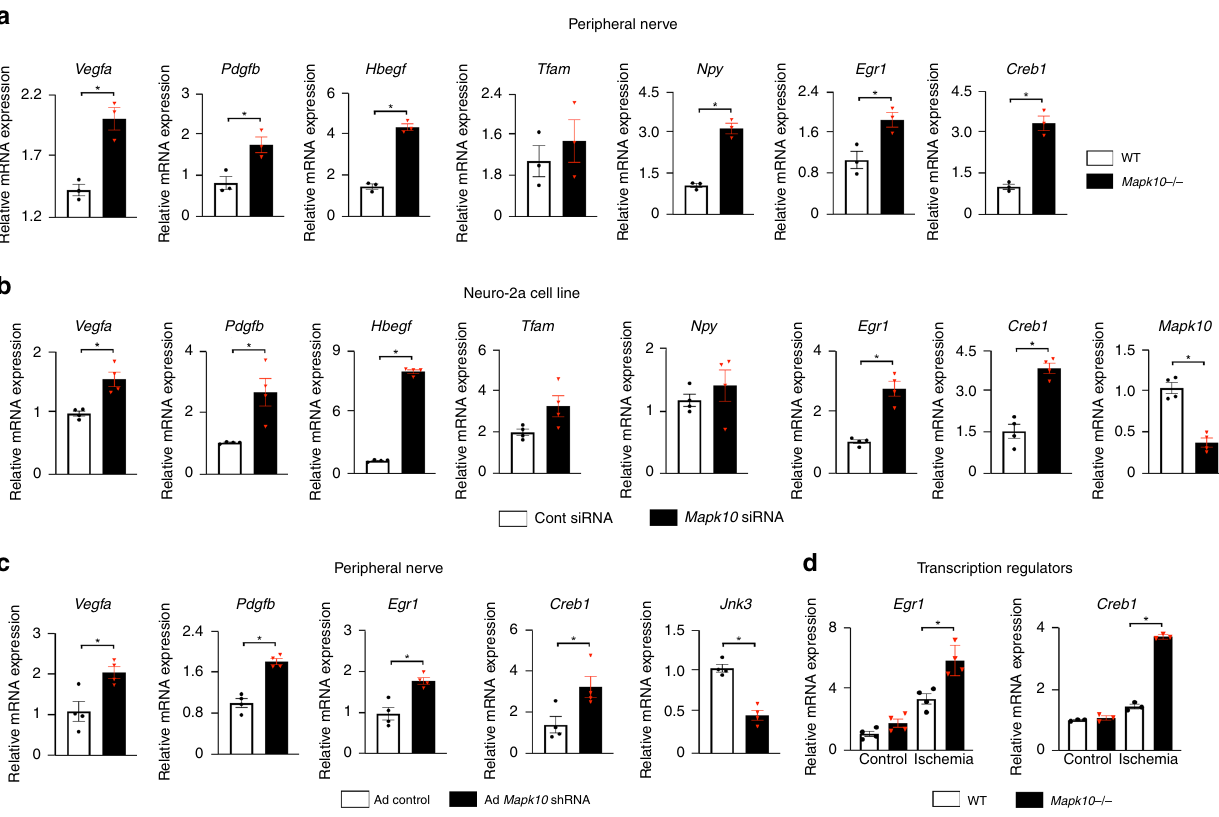
Fig. 4 JNK3 regulates pro-angiogenic factors expression in femoral nerve and Neuro-2a (N2a) cell lines. a Femoral nerves were isolated on day 3 after femoral artery ligation and qRT-PCR was performed for different blood fl ow recovery related genes ( n = 3 in each group). b Following 90 min of hypoxia, RNA was isolated from control and JNK3 knockdown N2a cells and qRT-PCR was performed for genes as indicated ( n = 4 in each group). c Femoral nerves were isolated from control and ischemic legs of mice after 48 h of gene painting with adenovirus expressing Mapk10 shRNA and qRT-PCR was performed for genes as indicated ( n = 4 in each group). d Gastrocnemius muscle was isolated from control and ischemic legs of mice on day 3 after femoral artery ligation and qRT-PCR was performed as indicated. Statistically signi fi cant differences between groups are indicated (* P < 0.05 by Student ’ s t test). The data are mean ± SEM. Source data are provided as a Source Data fi